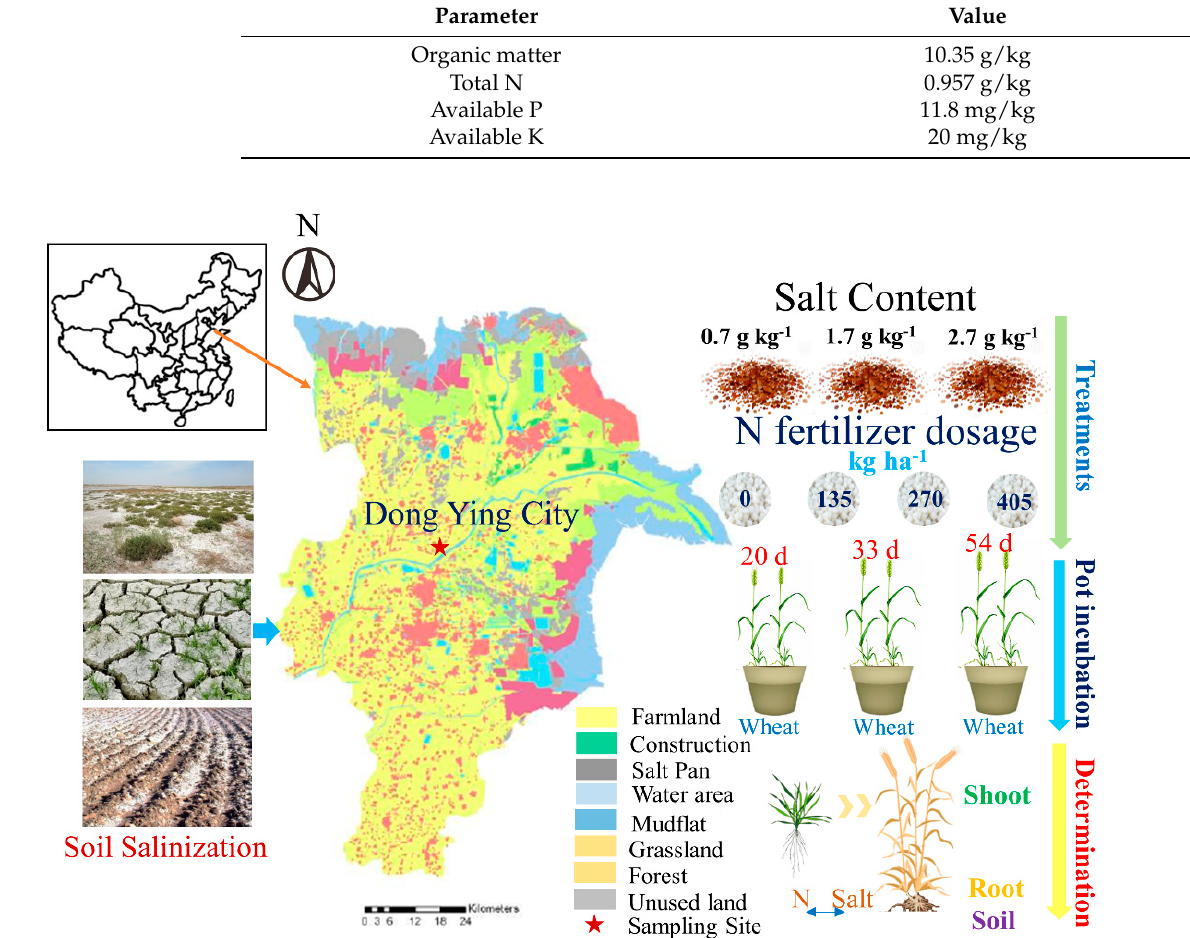
Table 2. The abbreviations of all treatments.